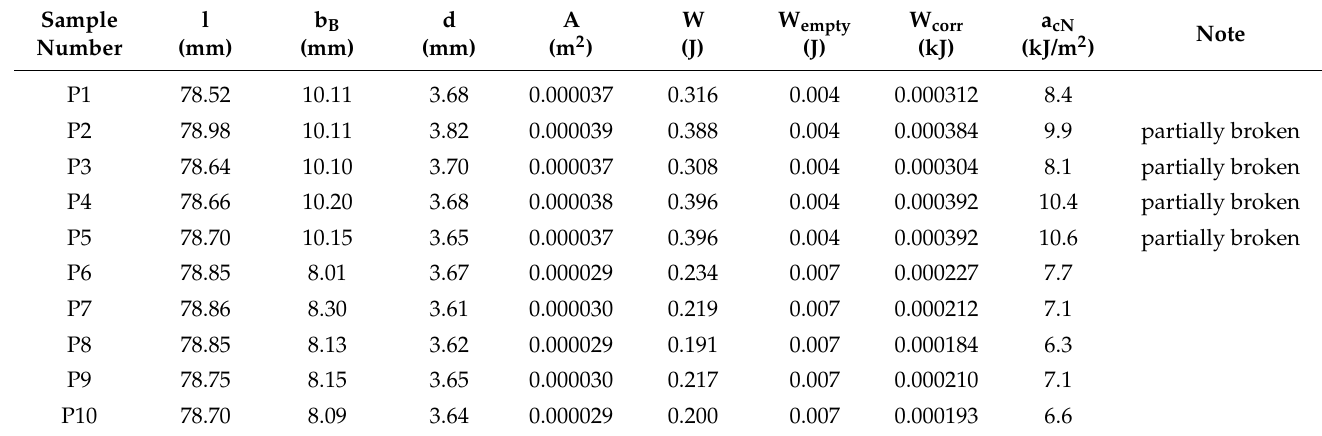
Table A19. Results of the notched impact tests and unnotched impact tests of PO_A,W.